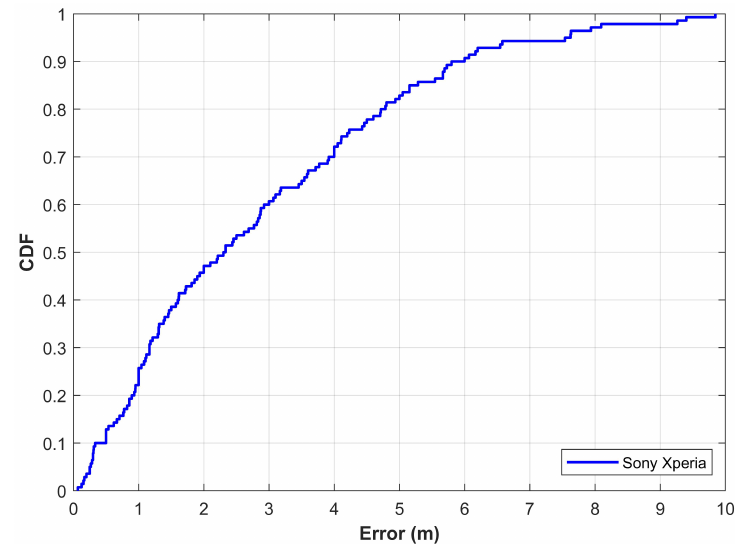
Figure 13. The CDF graph for localization with magnetic data from Barsocchi et al. [56].